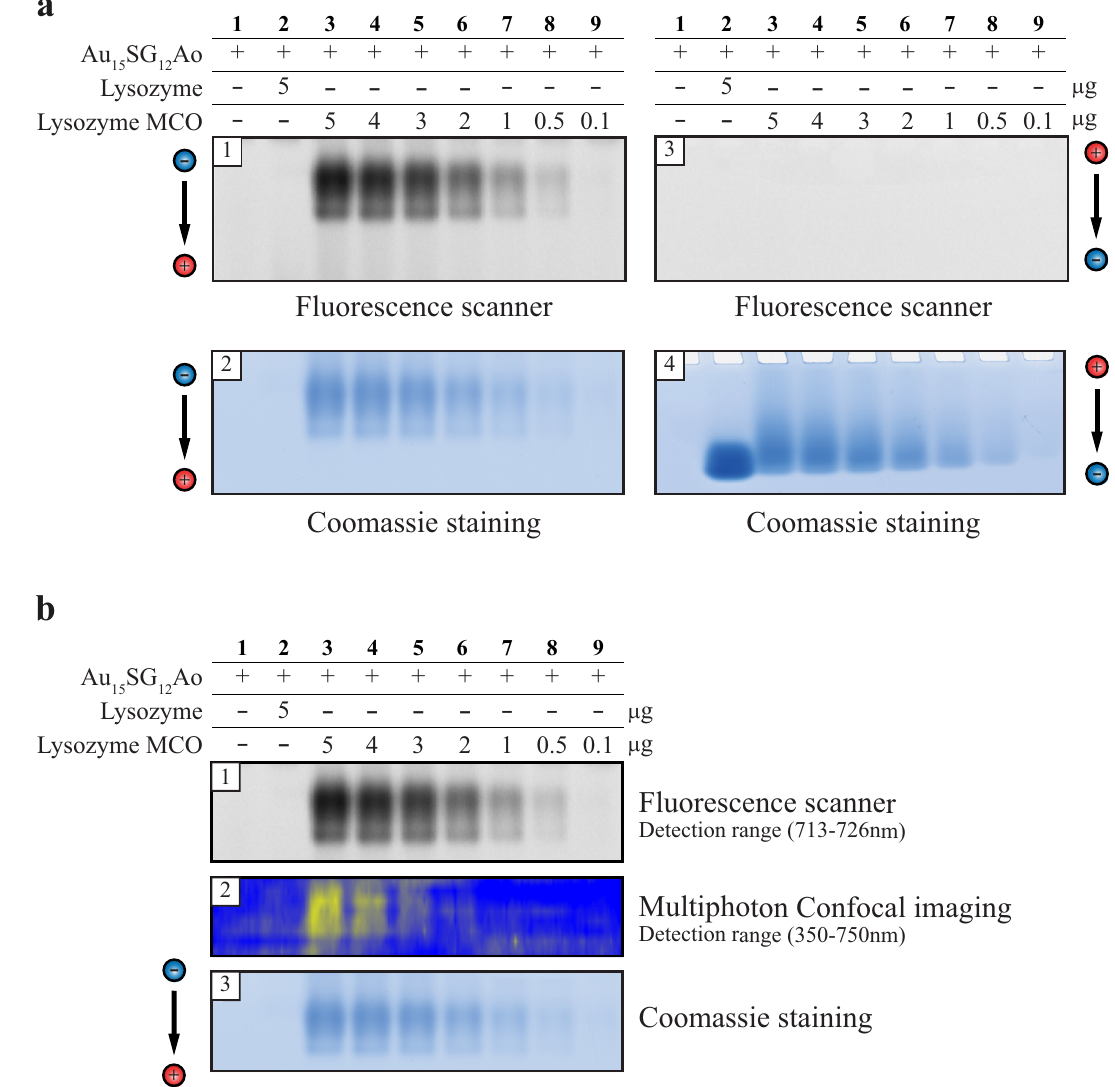
Fig. 4 Au 15 SG 12 -Ao in-gel signal responds to the lysozyme quantity. a The in-gel signal of Au 15 SG 12 -Ao decreases with the lowering of the oxidized lysozyme amounts. Gels 1 and 3 were dried and imaged using a fl uorescence scanner. Gels 2 and 4 were stained using Coomassie staining and images were obtained using a gel scanner. The displayed images are representative of three replicates. b Comparison of Au 15 SG 12 -Ao for detection of carbonylated proteins in gels by one-photon excited fl uorescence scanner and multiphotonic (two-photon excited fl uorescence) confocal imaging. The displayed images are representative of three replicates. Source data and replicates for ( a ) are provided in Supplementary Data 1 Figs. S9 – 11 and source data for ( b ) is provided in Supplementary Data 1 Fig.